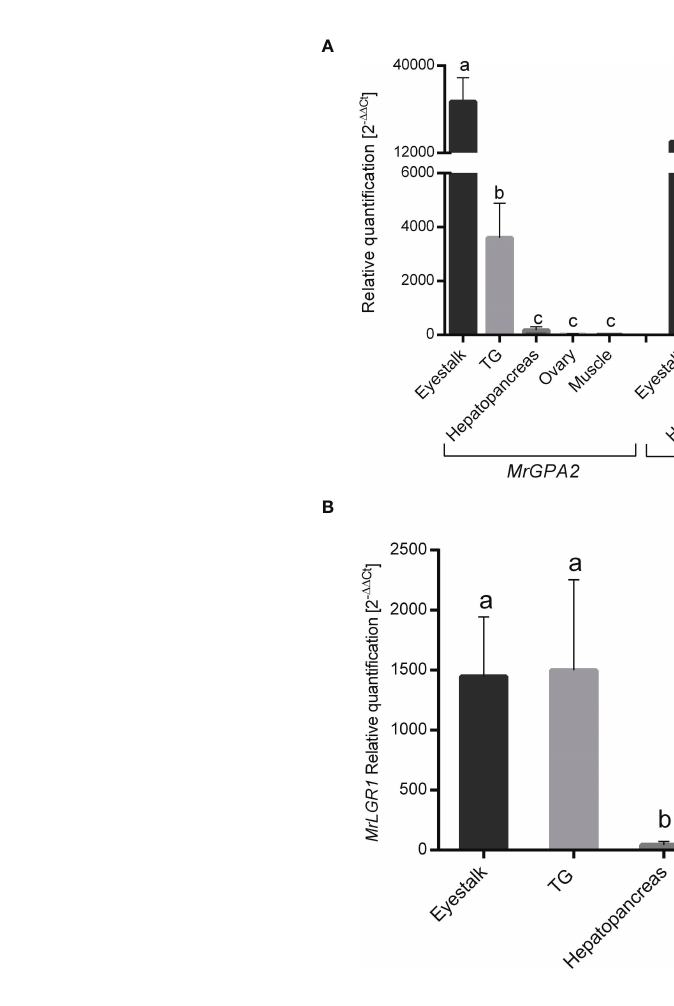
FIGURE 4 | Spatial expression patterns in M. rosenbergii females. Relative quanti fi cation in the eyestalk, thoracic ganglion (TG), hepatopancreas, ovary and muscle of (A) MrGPA2 and MrGPB5 and (B) MrLGR1 in adult females (n = 12). Error bars represent standard error of the means and different letters on the bars indicate statistically signi fi cant differences ( P < 0.05 , one-way ANOVA post hoc Tukey ’ s